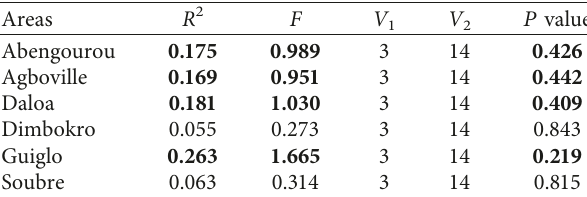
Table 2: Statistic of the Fisher–Snedecor test. Areas